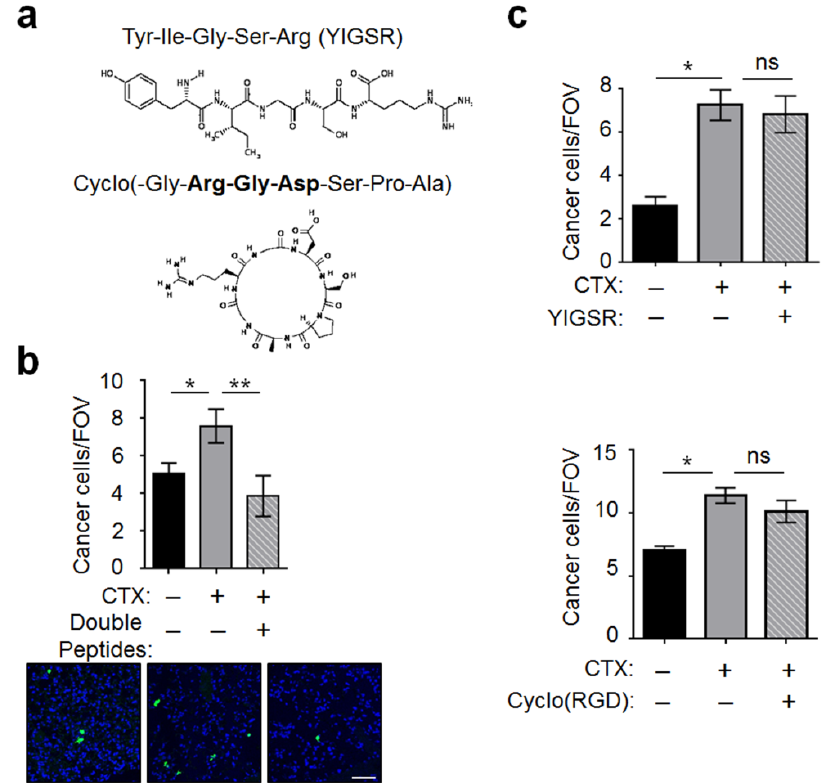
Figure 7. The YIGSR and cyclo(RGD) peptides derived from ECM proteins dampened the ability of CTX to increase vascular adhesiveness. ( a ) Schematics and sequences of the peptides. ( b ) Cancer cells were incubated with the YIGSR and cyclo(RGD) double peptides for 20 min before injection into mice pre-treated with CTX (+) or vehicle (−). Cancer cell number per FOV at 3 h after injection were analyzed ( n = 8–9 from 2 independent experiments). Bottom : Representative images. ( c ) Same as in ( b ) except single peptide was used: YIGSR (top) and cyclo(RGD) (bottom) ( n = 6–8 from 2 independent experiments). Scale bar, 50 μm. Bars indicate mean ± SEM; one-way ANOVA with post hoc Holm–Šídák correction; * p < 0.05; ** p < 0.01; ns: not significant.